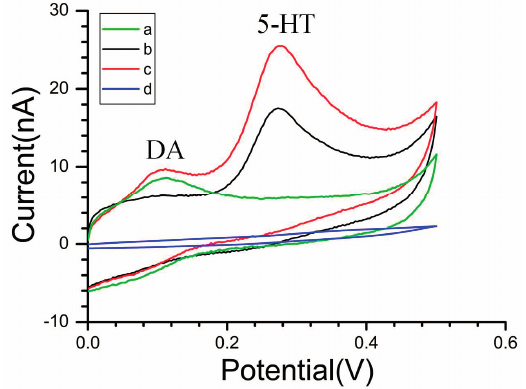
Figure 2. Cyclic voltammetry (CV) of dopamine (DA) and 5-hydroxytryptamine (5-HT) in pH 7.4 phosphate buffer, on CS-MWCNT hybrid film-modified MEA with 50 μ M DA (a),